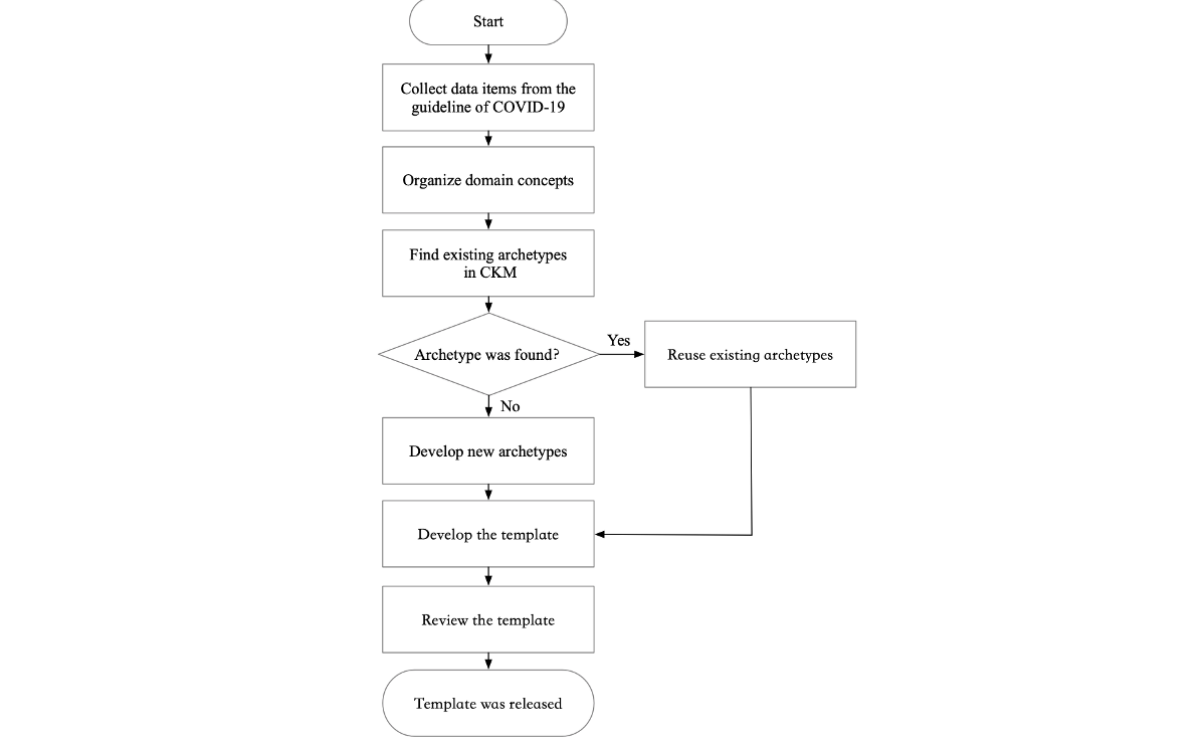
Collecting Data